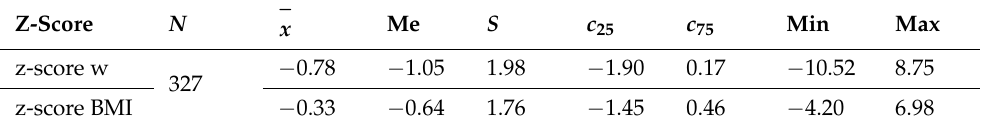
Table 2. Numerical characteristics of the z-score, z-score w and z-score BMI. ¯ Z-Score N x Me S c 25 c 75 Min Max − 0.78 − 1.05 1.98 − 1.90 0.17 − 10.52 8.75 z-score w 327 z-score BMI − 0.33 − 0.64 1.76 − 1.45 0.46 − 4.20 6.98